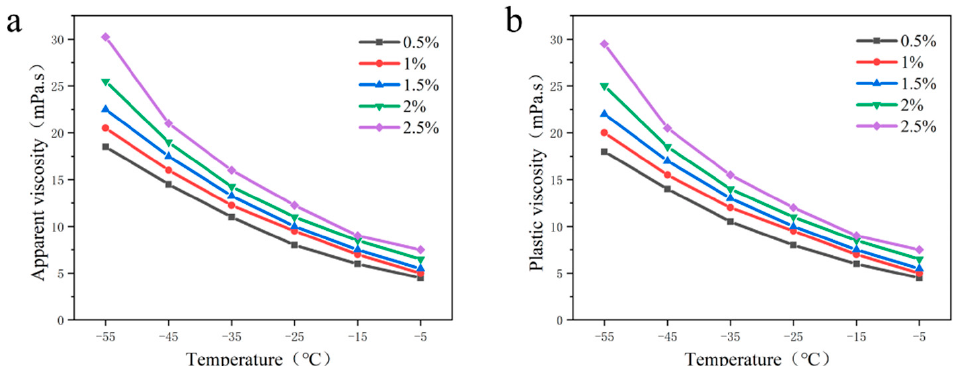
Figure 9. Effects of the different concentrations of vinyl resin on the rheological properties of drilling fluid; ( a ) apparent viscosity; ( b ) plastic viscosity.